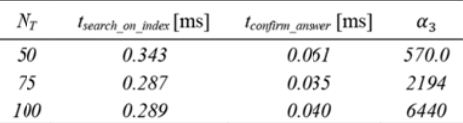
able 4. The tim and the